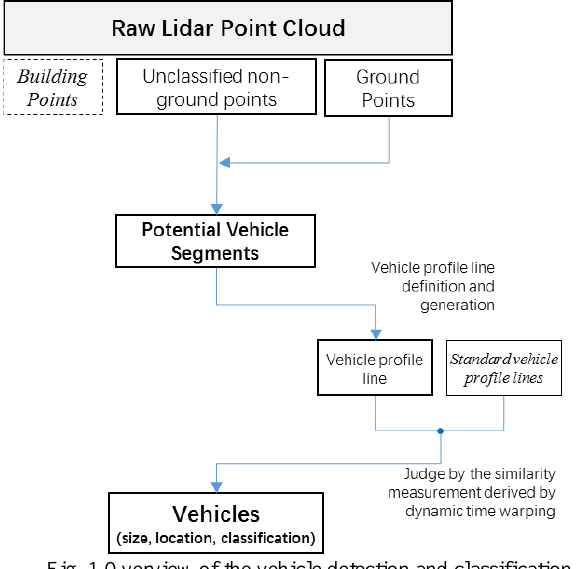
Fig. 1 Overview of the vehicle detection and classification